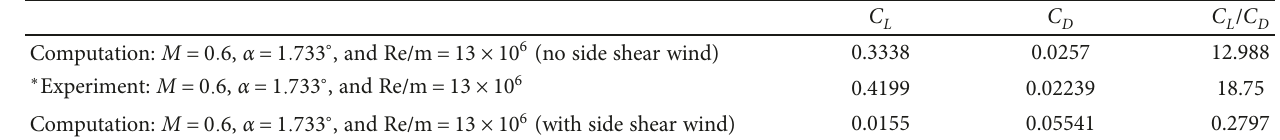
C C / C C L D L D